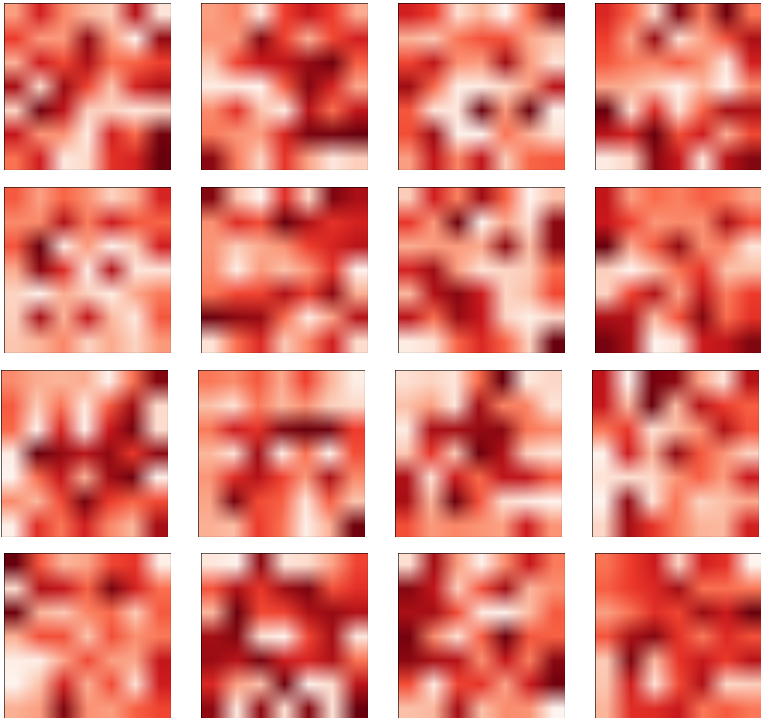
Figure 4. Randomly selected filters from the first convolutional layer as configured after the learning process. Darker regions correspond to the most important learned weights while brighter ones have a lower impact on the convolution